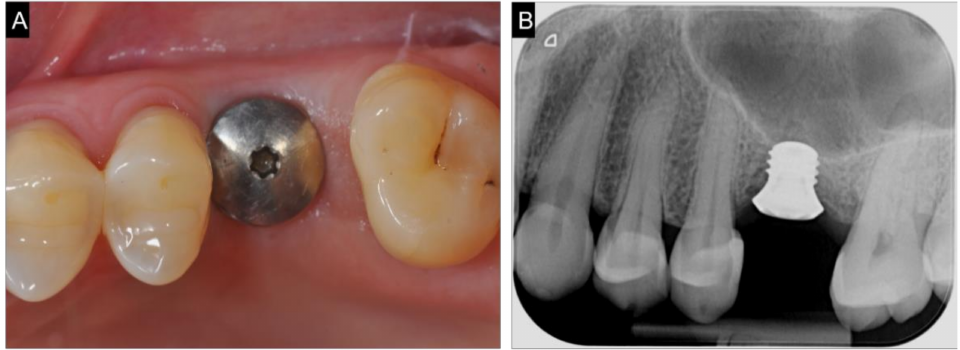
Figure 5. Clinical ( A ) and radiological ( B ) view after implant